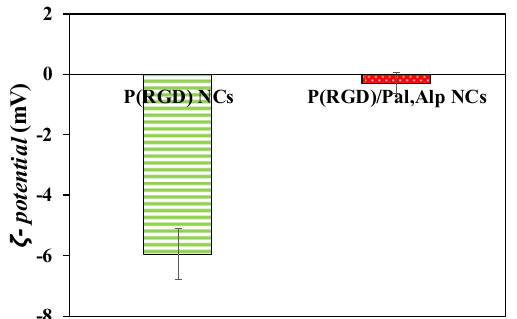
Figure 5. ζ -potentials of P(RGD) and P(RGD)/Pal,Alp NCs.